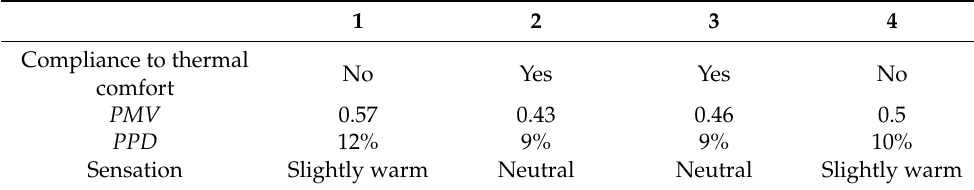
Table 4. Thermal comfort comparison between the four